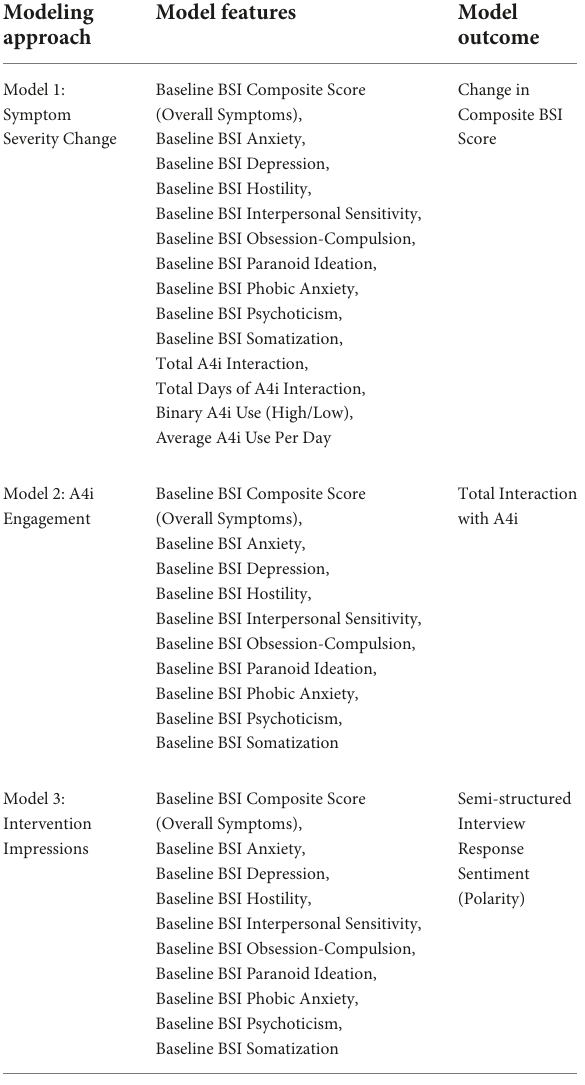
TABLE 1 Machine learning model corresponding hypotheses, features and